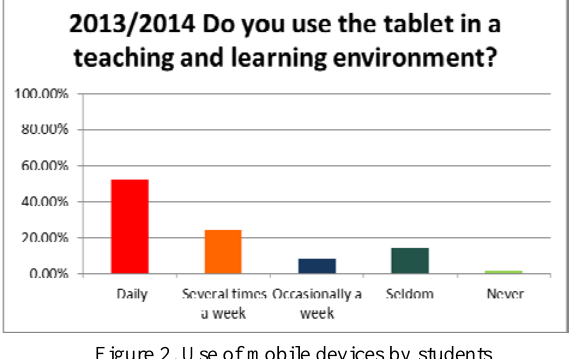
and would not prefer to use paper handouts anymore (Figure